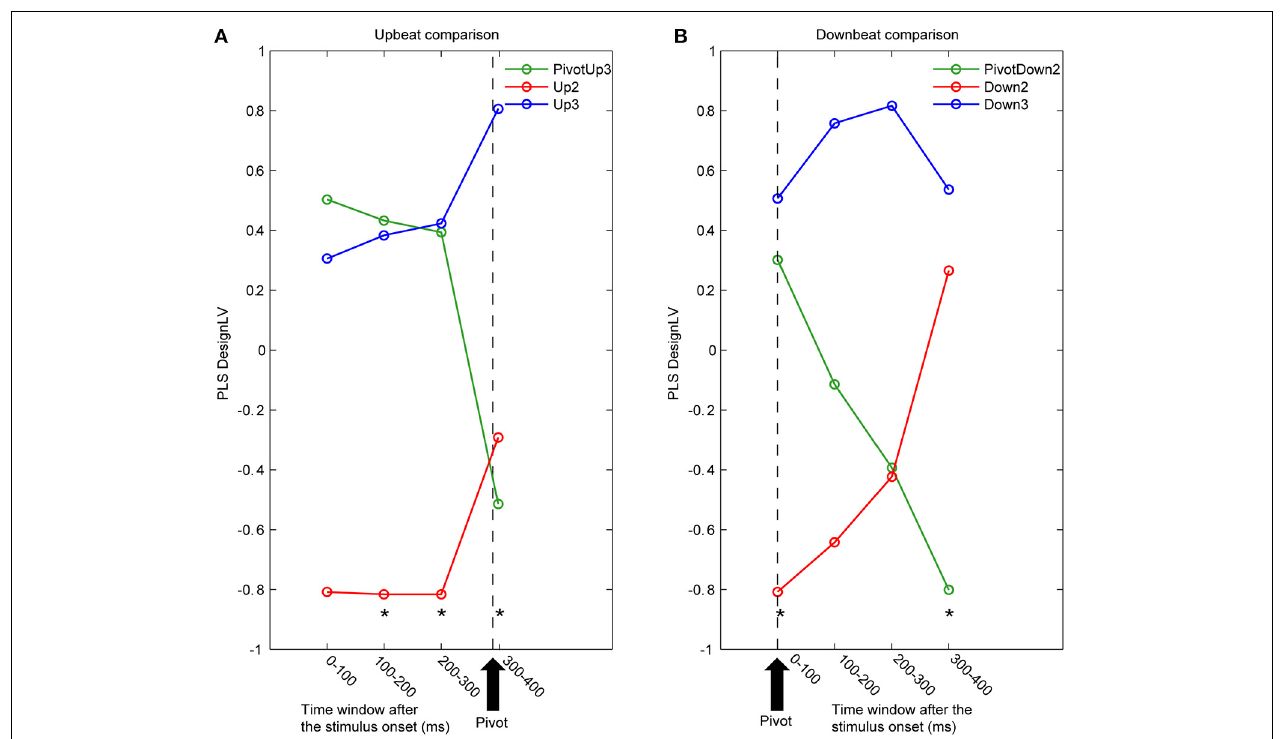
FIGURE 5 | Time courses of latent variables accounting for the contrast between three metric conditions. The partial least squares analysis (PLS) was performed for contiguous 100ms time intervals for (A) upbeat positions